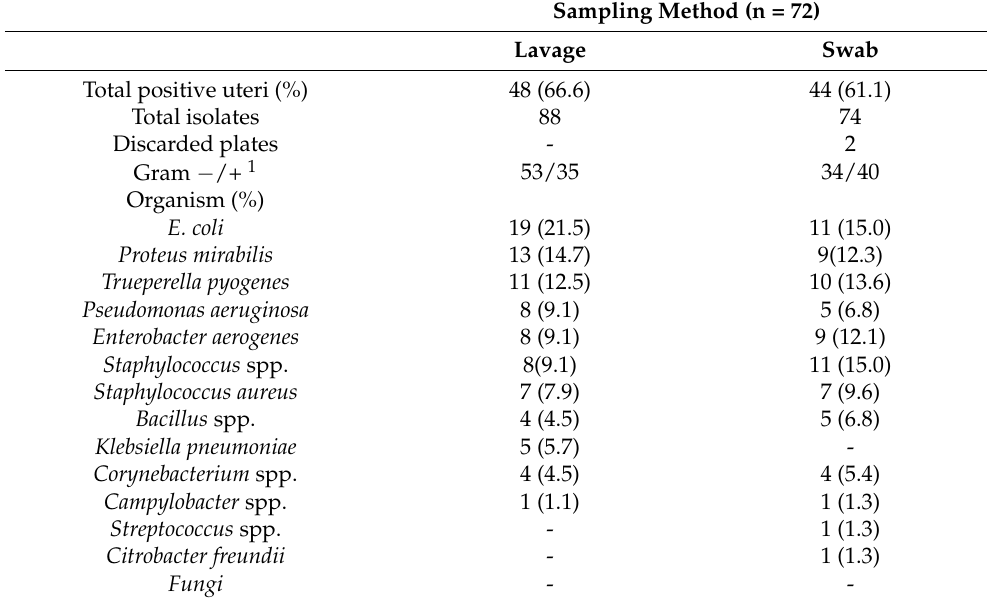
Table 1. Bacterial isolates from the uteri of subfertile camels obtained by different sampling methods.